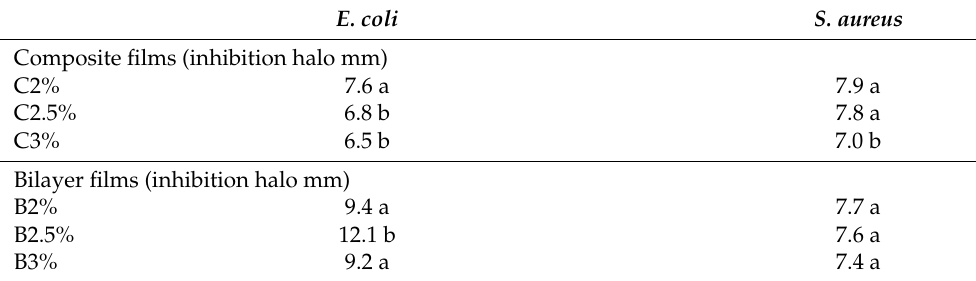
Figure 6. Halo test results of the bilayer and composite films with E. coli and S. aureus bacteria. Table 4. Measurements of inhibition halos obtained by the agar diffusion method.